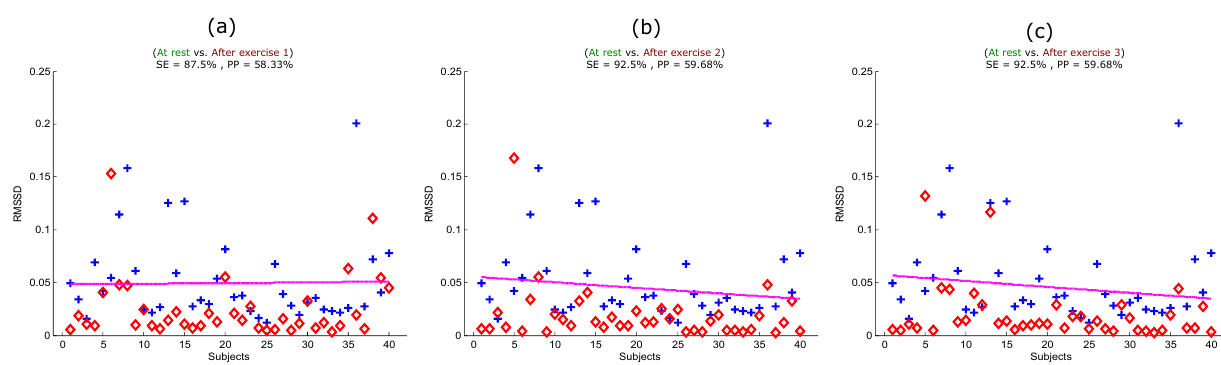
59.68%(At rest vs. After exercise 1) SE = 87.5% , PP = 58.33%